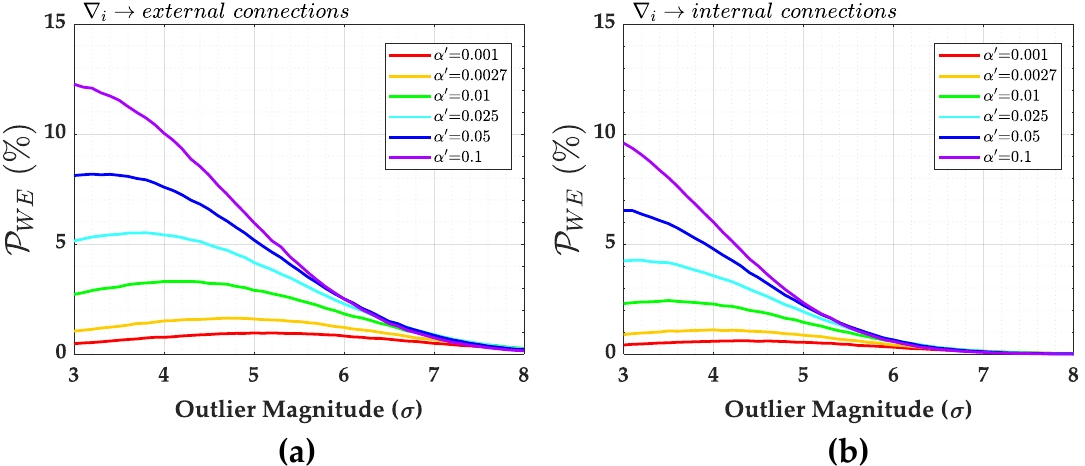
Figure 10. Probability of committing a Type III decision error ( P WE ) for network ( a ): ( a ) P WE for external connections. ( b ) P WE for internal connections.